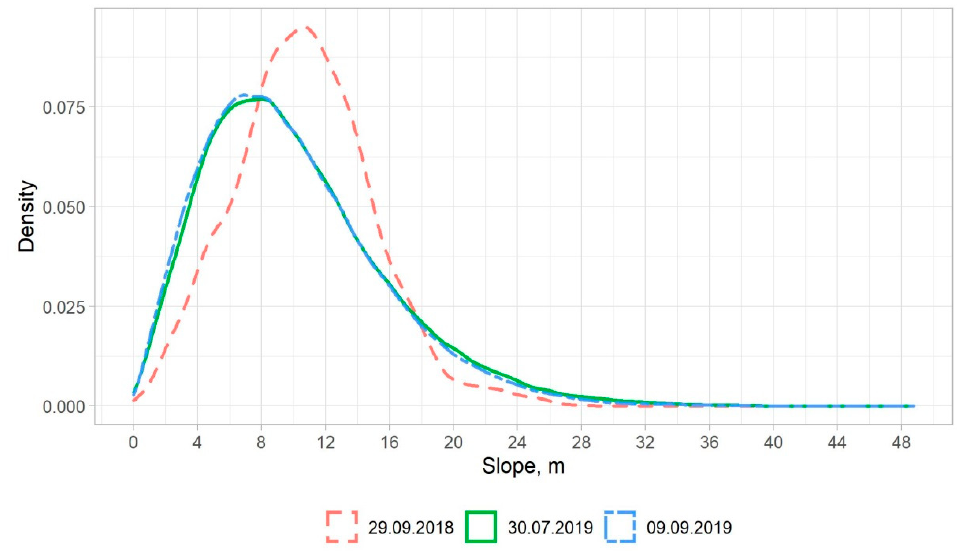
Figure 5. Distribution of damaged forest stands areas, depending on the terrain slope.